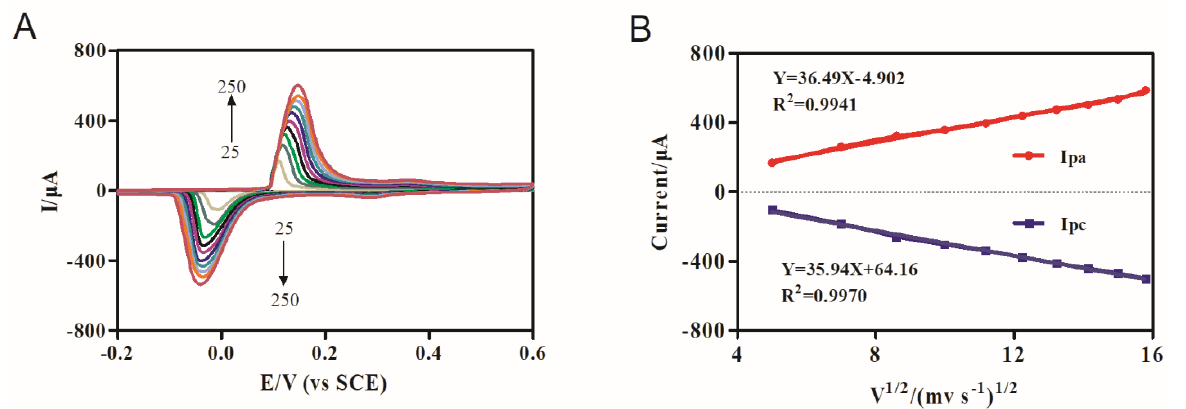
Figure 5. ( A ) CVs of the constructed electrochemical immunosensor at different scan rate: 25, 50, 75, 100, 125, 150, 175, 200, 250 mV s −1 . ( B ) The relationship between redox peak current and the scan